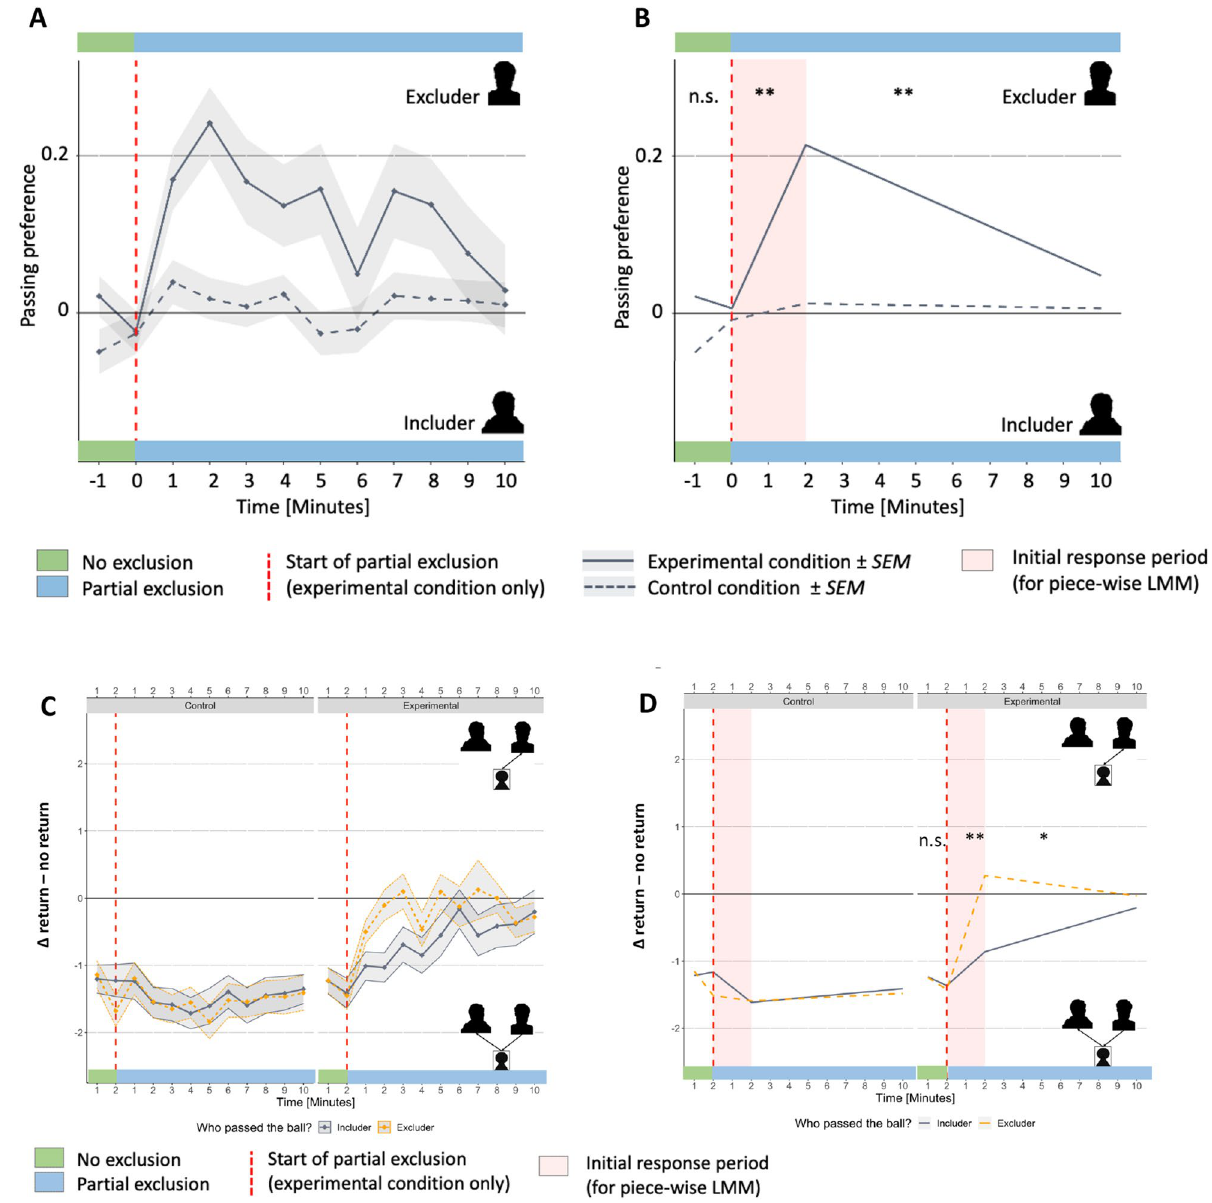
Figure 3. Experiment 2. ( A ) Mean passing trajectories over the course of experiment 2. Passing preferences (PP) were calculated for each minute according to formula [1]. The gray shaded area shows the associated standard errors of means. Dashed red line represents transition from period of no exclusion to partial exclusion period. ( B ) Predicted values of piecewise (Linear Mixed Model) LMM. ( C ) Δ return passes—no return passes were calculated for each minute. ( D ) Predicted values of piecewise LMM. 0 represents a balanced return versus no return behavior, values < 0 represent more return playing, values > 0 represent forwarding playing. Asterisks represent significant period × condition interactions. * p < 0.05; ** p < 0.01; *** p <